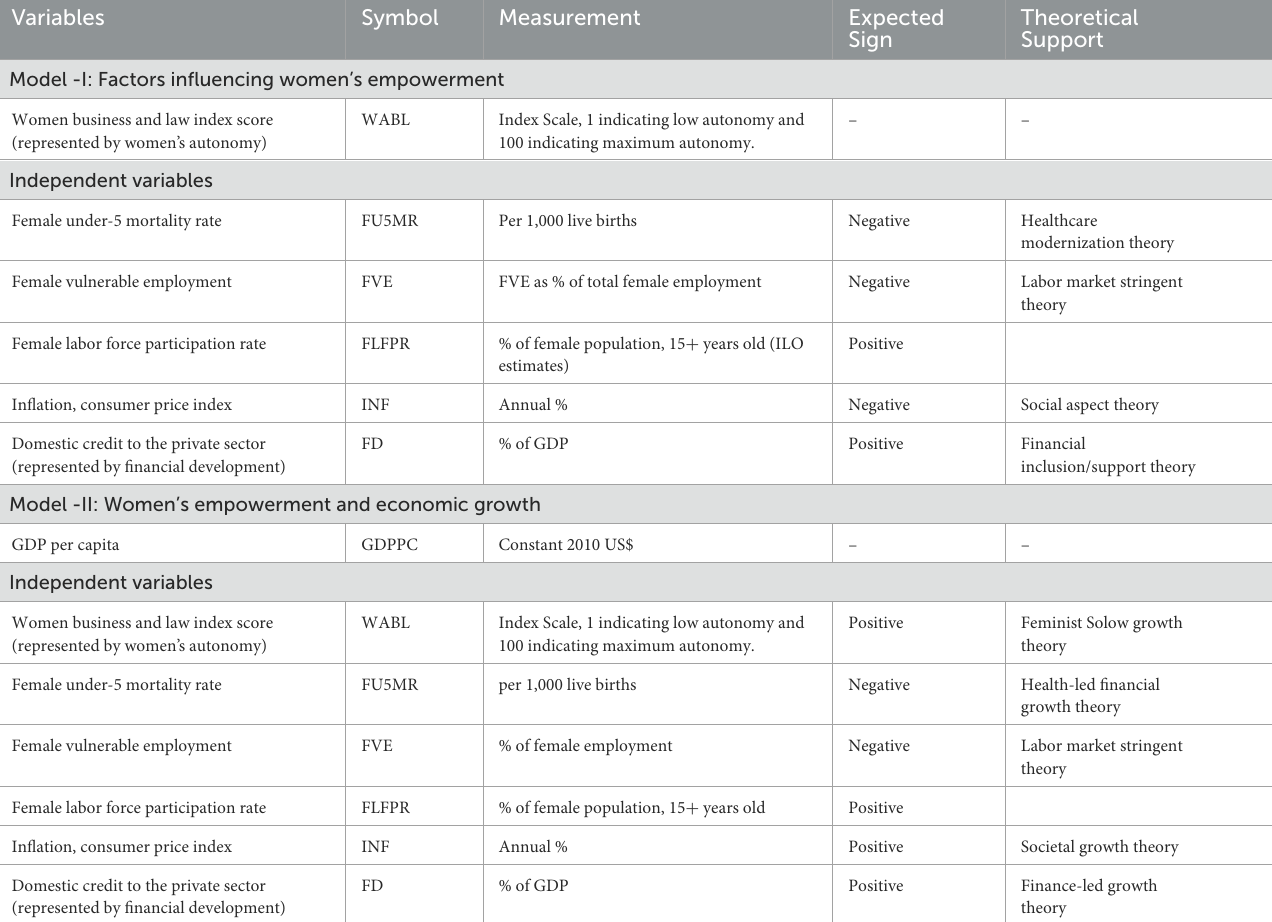
TABLE 1 List of variables and theoretical expectations. Variables Symbol Measurement Expected